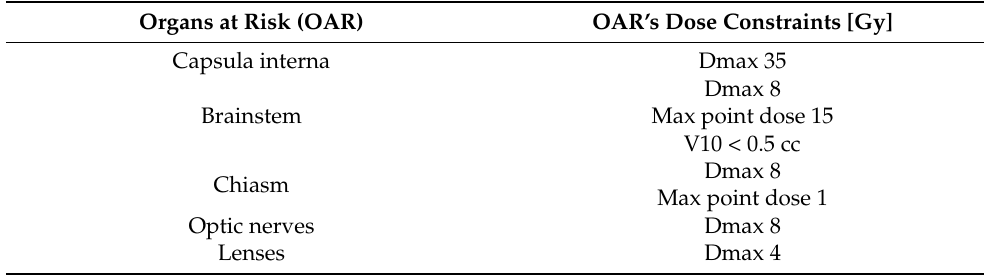
Table 1. Dose constraints for nearby organs at risk. Organs at Risk (OAR) OAR’s Dose Constraints [Gy] Capsula